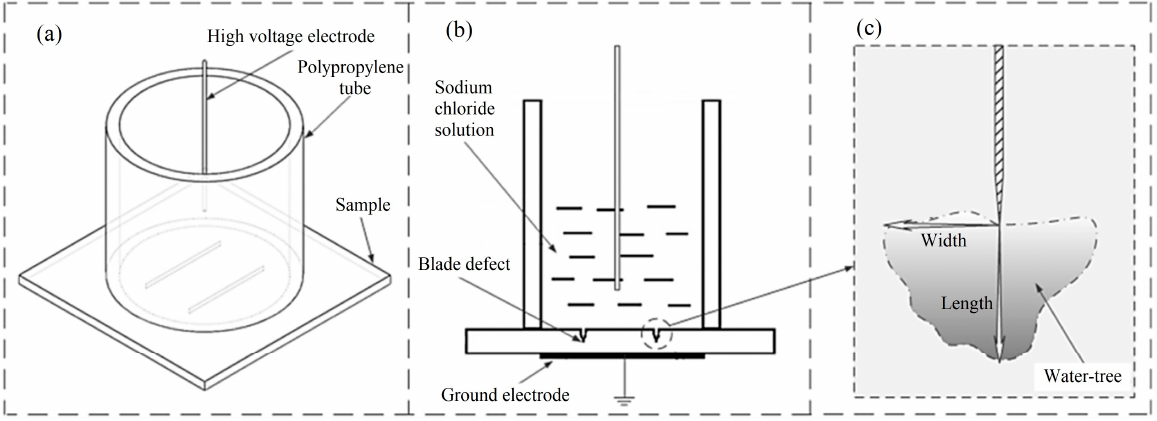
Figure 9. Schematics of accelerated water-tree aging experiments with a water blade electrode: ( a ) overview, ( b ) side sectional view, ( c ) generating water-tree.